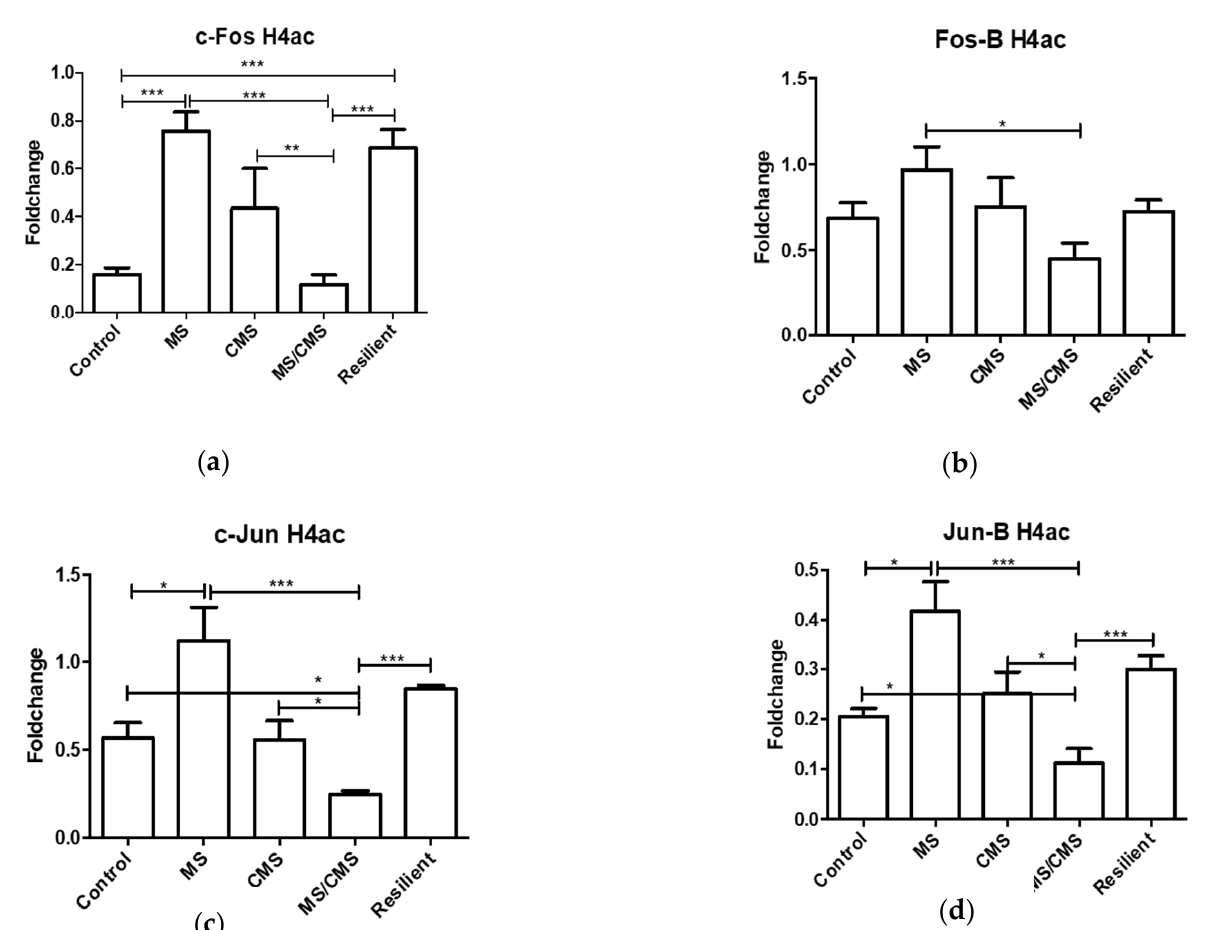
Figure 4. Association of histone H4 acetylation (H4ac) with different immediate early genes (IEG) promoters: ( a ) c-Fos; ( b ) Fos-B; ( c ) c-Jun; ( d ) Jun-B Results presented as fold change with respect to a control gene promoter ( ActB ). * = p < 0.05, ** = p < 0.01, *** = p < 0.001. Data shown as mean fold change +/ − SEM .